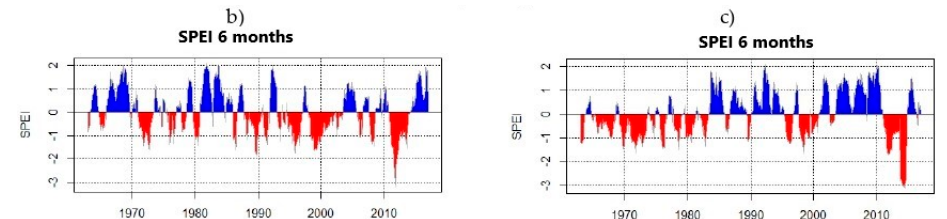
Figure 4. Associations of carbon accumulation by drought for: ( a ) Pinus strobiformis and Pinus leiophylla . The graphs show the correlation values ( r , Pearson) between carbon accumulation and the standardized precipitation and evapotranspiration index (SPEI) drought index on scales from 1 to 24 months (x-axes), calculated from January to December (y-axes); correlations greater than r = 0.35 are significant ( p < 0.01). ( b , c ) show the SPEI drought index (period 1962–2016) for the El Salto and Otinapa stations, respectively; the blue and red bars indicate positive and negative SPEI values corresponding to wet and dry conditions, respectively.